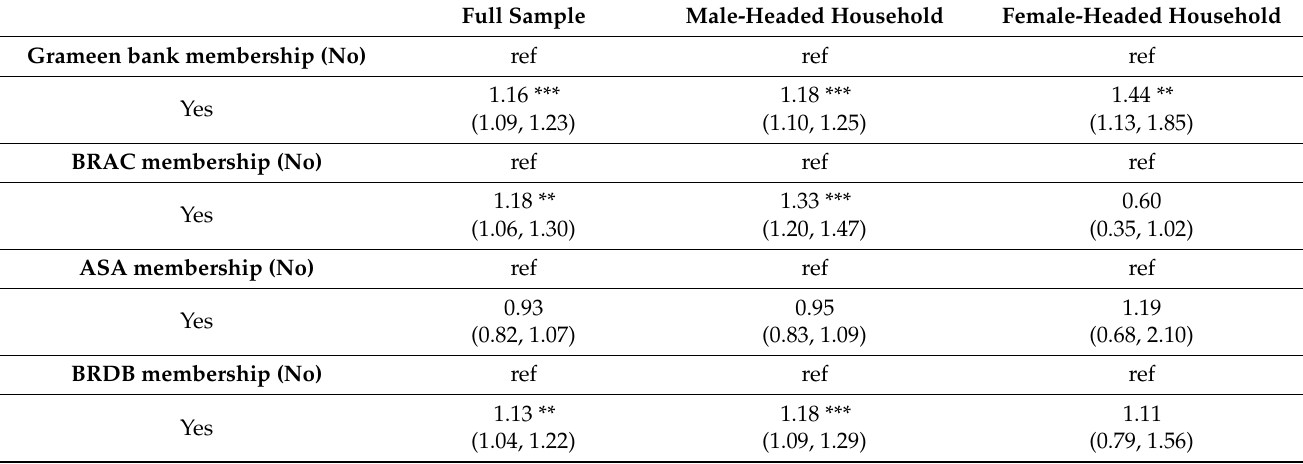
Odds ratios of association between microcredit membership and HA among Bangladeshi women. Full Sample Male-Headed Household Female-Headed